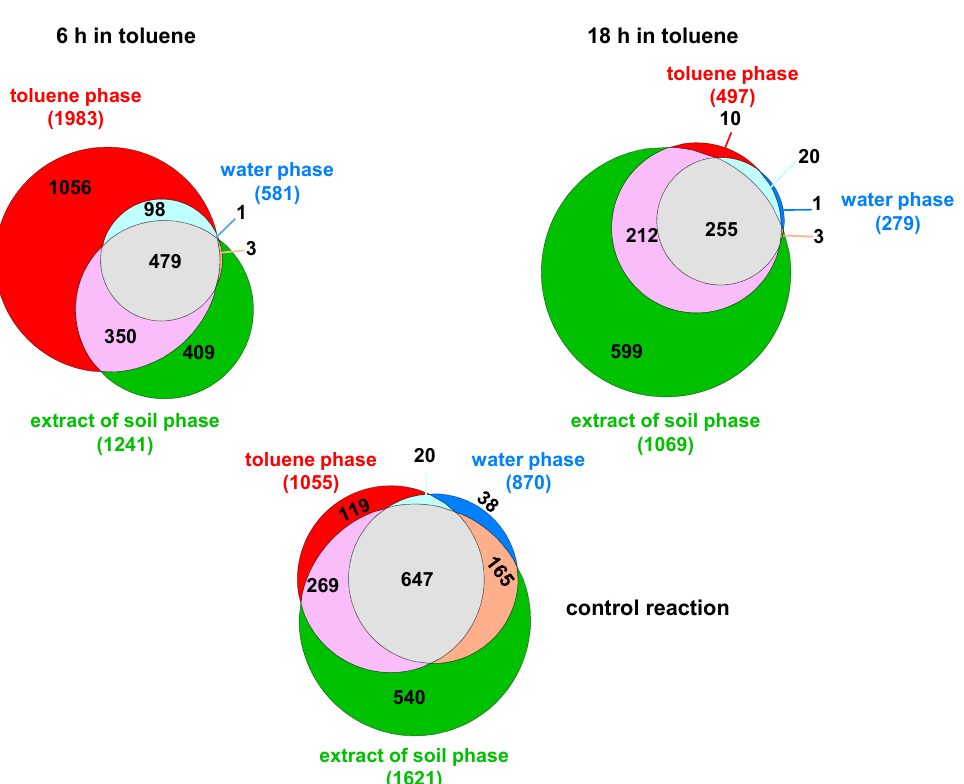
Figure 4. Population-based area-proportional Venn diagrams for radical HC species of different phases from control reaction (middle), ozonation within 6 h in toluene (top left) and within 18 h in toluene (top right).